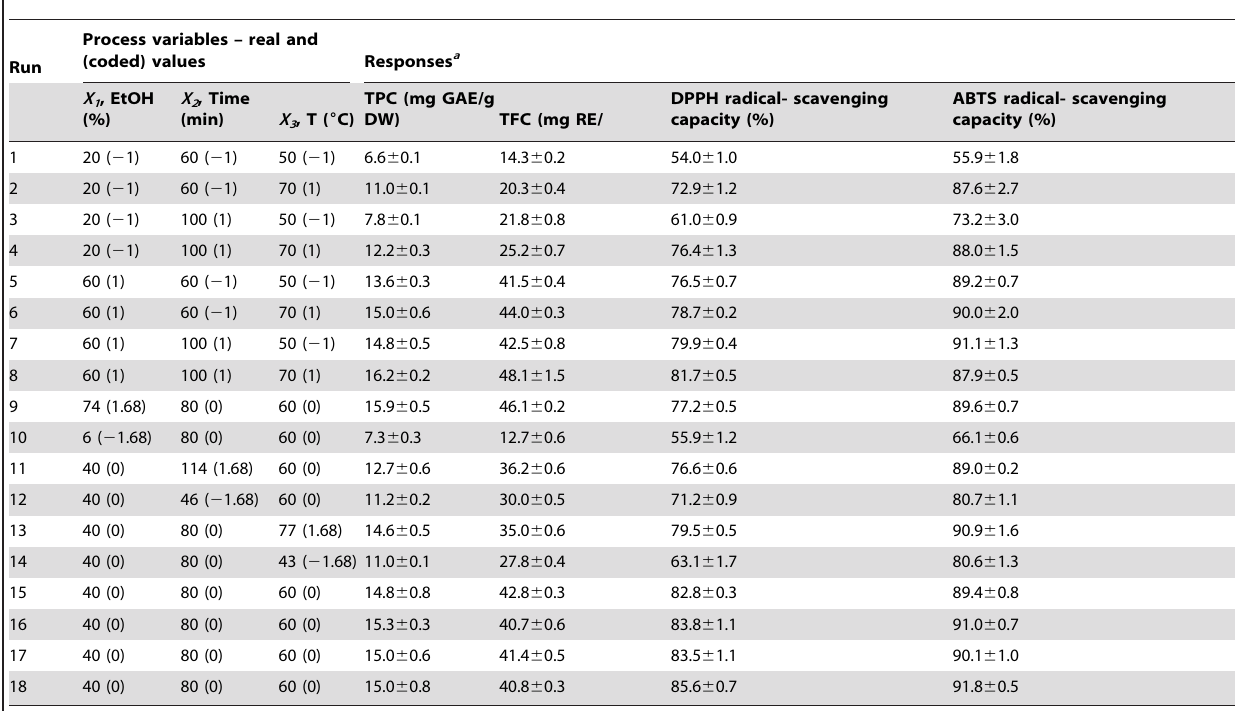
Table 1. Five-level, three-independent variable central composite rotatable design and experimental data for response variables for optimization of C. cyrtophyllum leaf